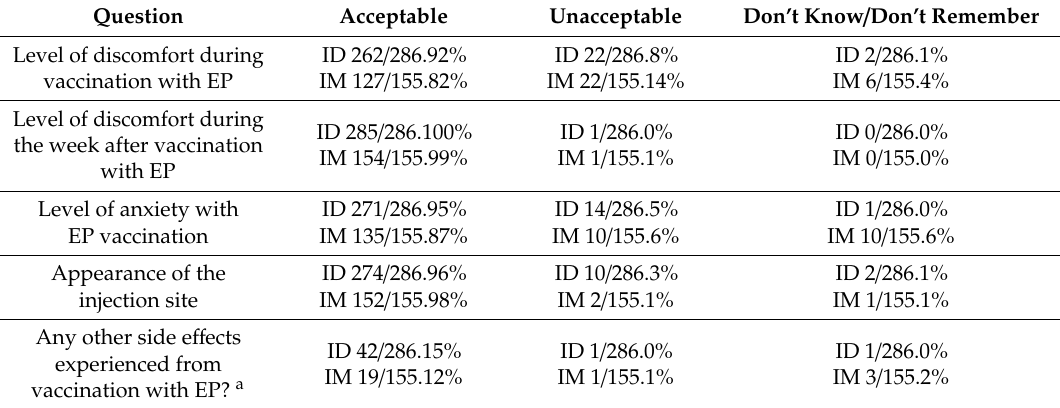
Table 2. Acceptability of intramuscular (IM) and intradermal (ID) vaccination with electroporation (EP). Responses from two weeks after each injection and six months after final injection, combined.